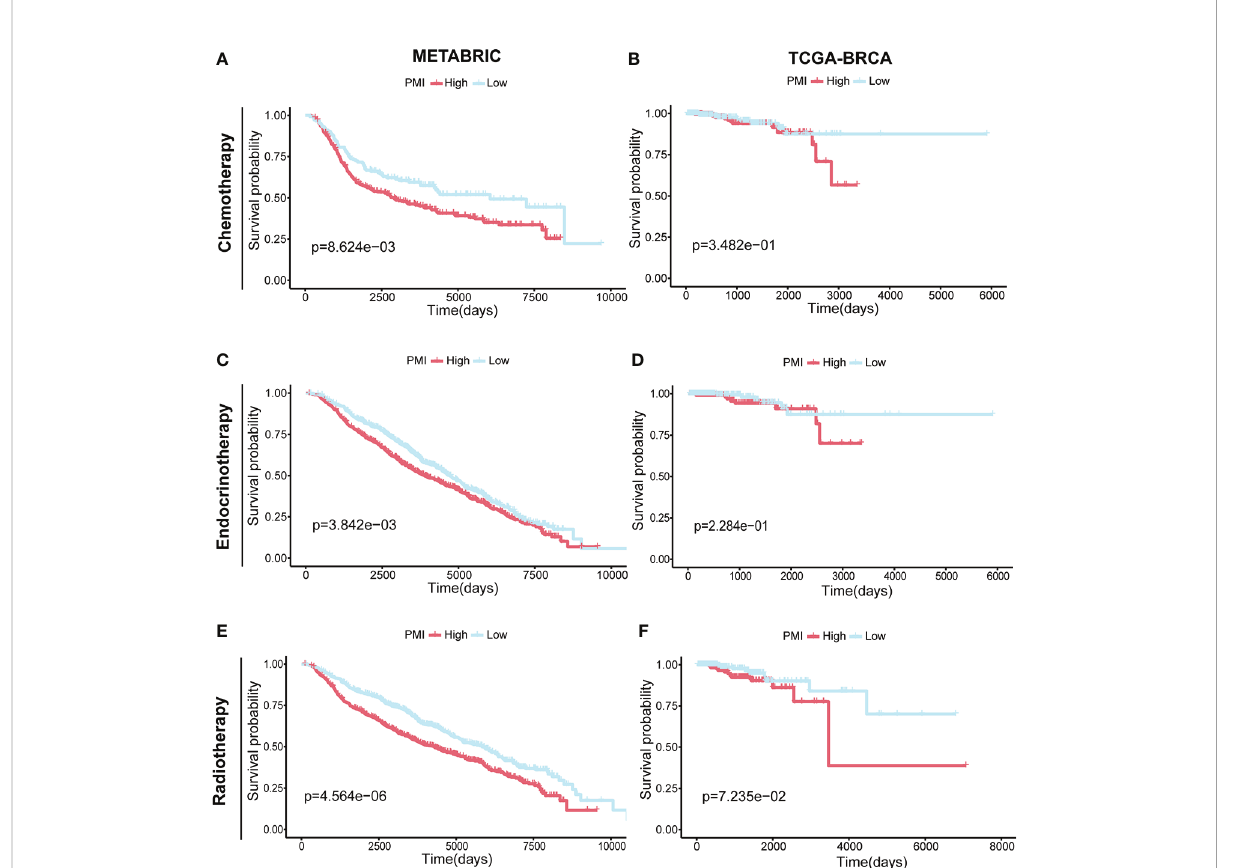
FIGURE 11 Prognostic Investigation of PMI in BC Patients Receiving Different Treatments.KM analyses of overall survival probabilities between the high- and low-PMI subgroups in BC patients undergoing chemotherapy (A, B) , endocrinotherapy (C, D) and radiotherapy (E, F) in the METABRIC and TCGA-BRCA cohort,